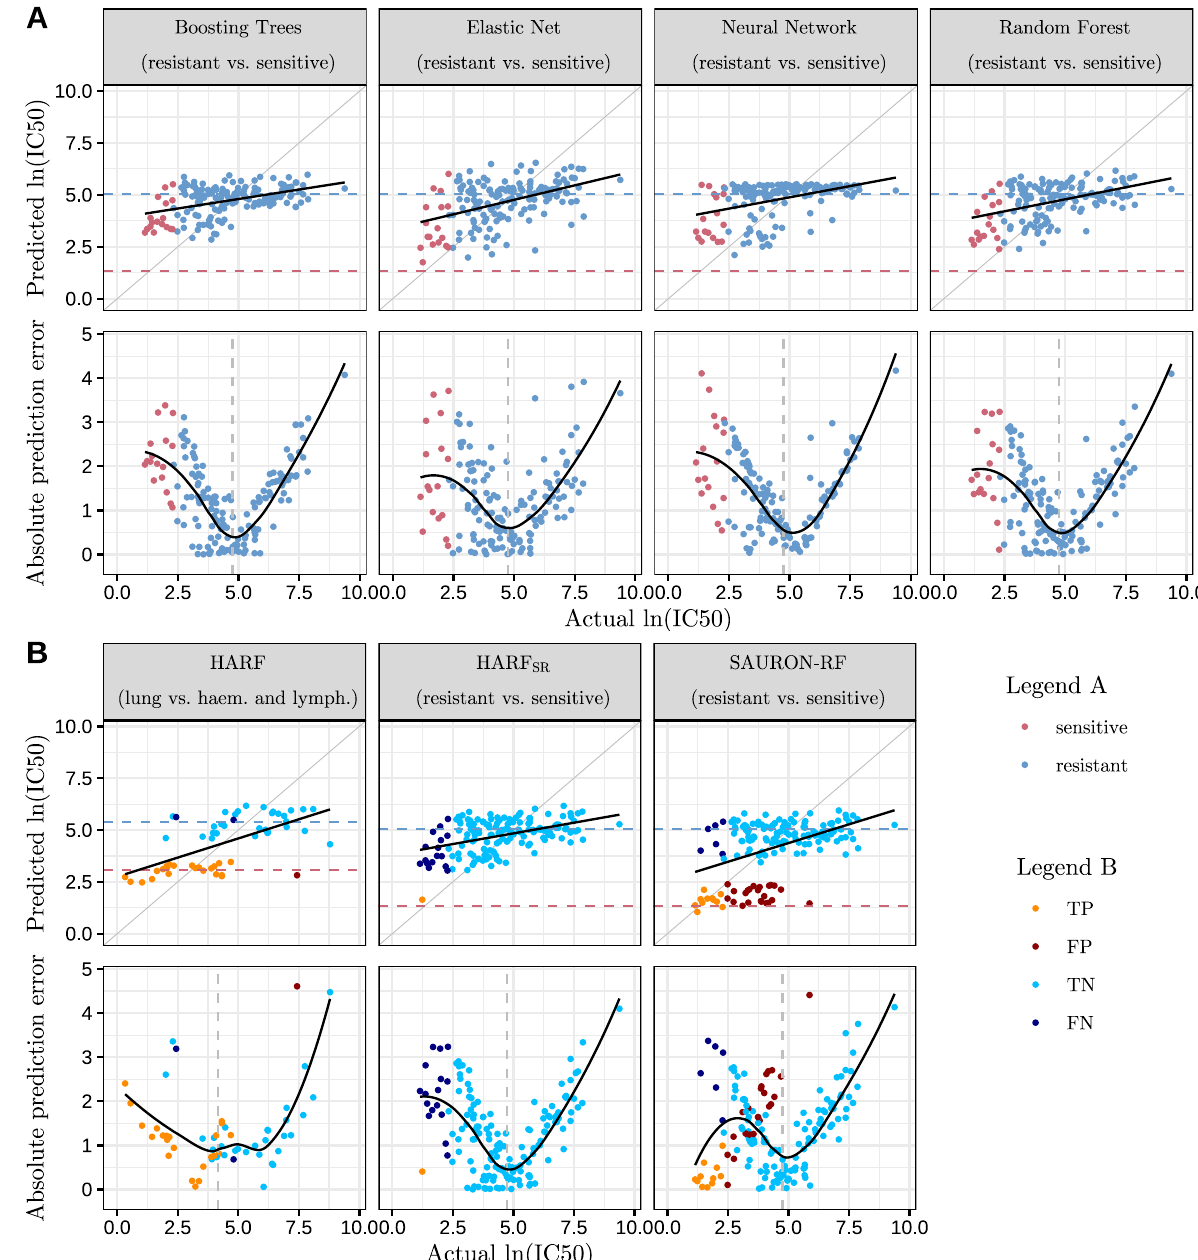
Figure 2. Regression performance of different ML methods. This figure exemplifies the performance of different ML algorithms when applied to the 5-Fluorouracil data set of the GDSC database using 20 input features. The upper rows of Fig. ( A ) and ( B ) show the predicted IC50 values plotted against the actual IC50 values including a fitted regression line, which is shown as a solid black line. The mean IC50 of training samples for each investigated class is depicted as a horizontal dashed line. The lower rows show the absolute prediction error. Here, the solid curve is a loess curve fitted to the error, the vertical dashed line gives the mean IC50 of all training samples. In Fig. ( A ), we compare boosting trees, elastic net, neural networks and random forests. The point coloring indicates the class assignment (sensitive or resistant). The first plot in Fig. ( B ) depicts the performance of the original HARF algorithm applied to a restricted version of this data set containing only cell lines from two cancer types with different average drug responses, i.e., haematopoietic/lymphoid cell lines and lung cell lines. The second plot shows the performance of HARF when applied to our proposed class division ( HARF SR ), and the last plot depicts the performance of the suggested SAURON-RF algorithm (SAURON-RF simple s.w., binary sens t.w.). Here, the point coloring represents the classification performance, i.e. we depict true positives (TP), false positives (FP), true negatives (TN), and false negatives